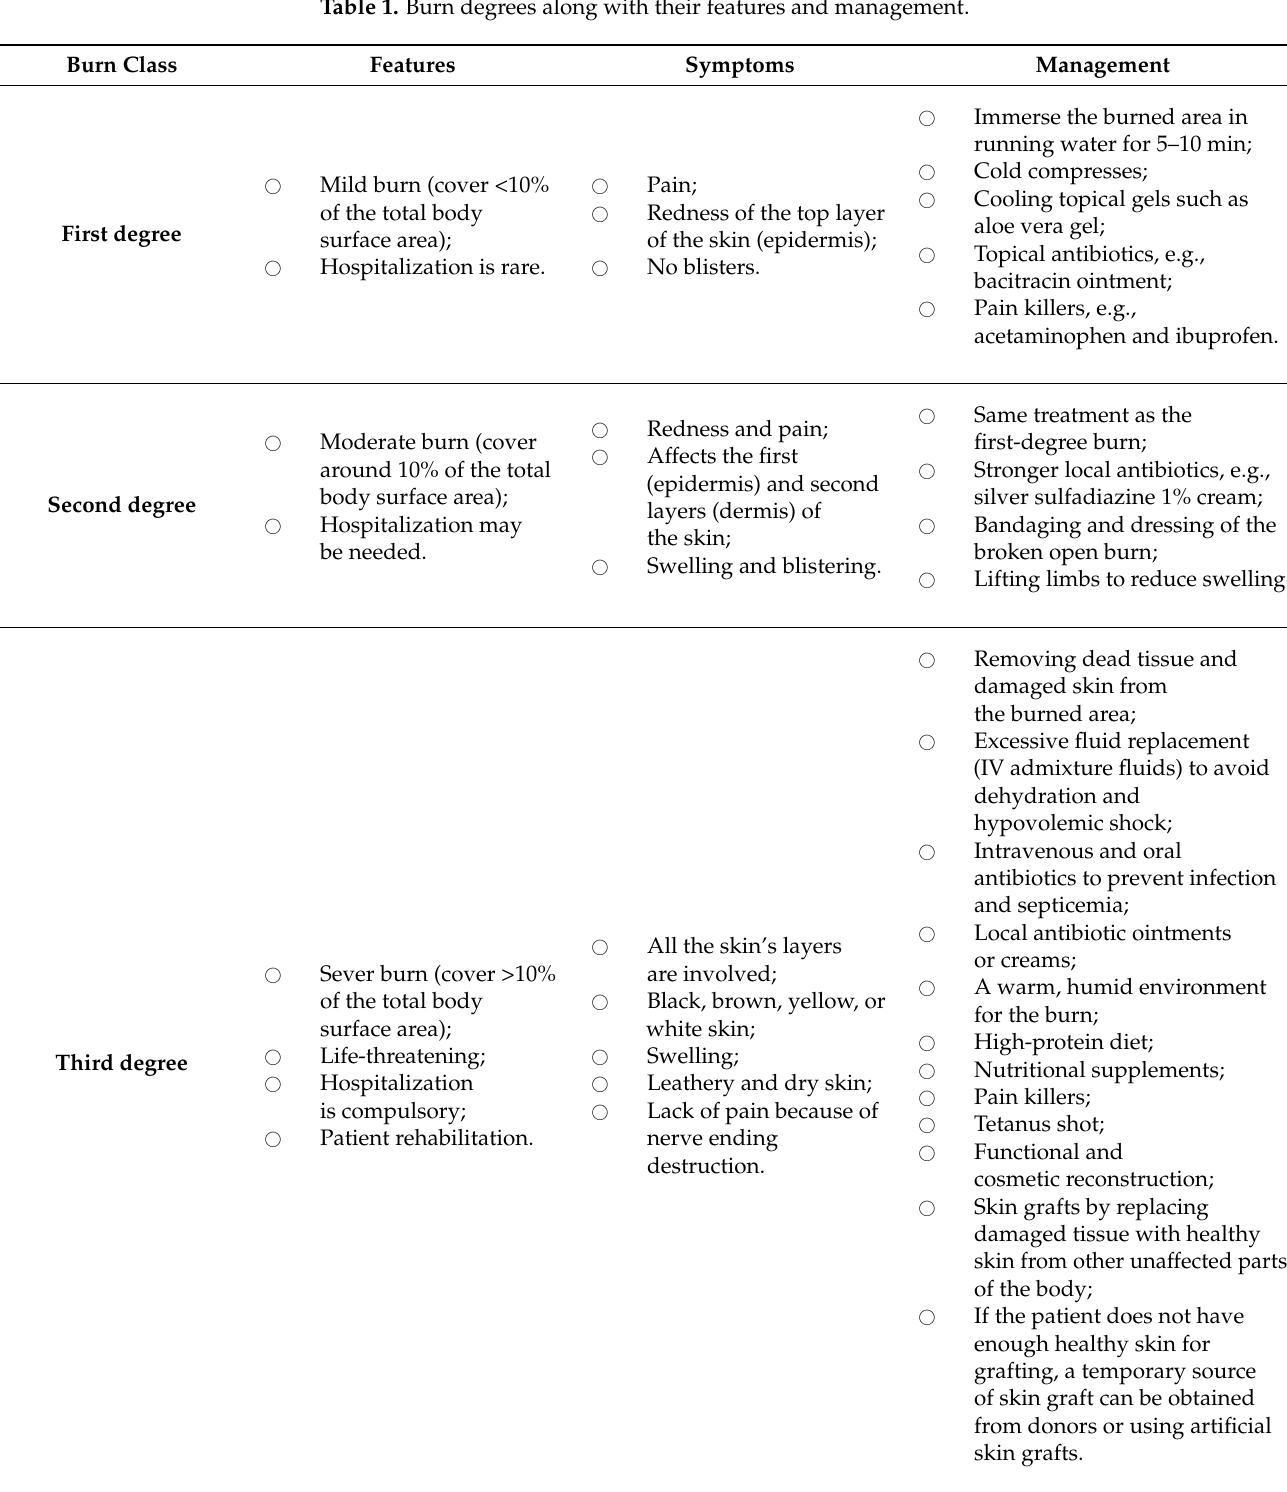
Table 1. Burn degrees along with their features and